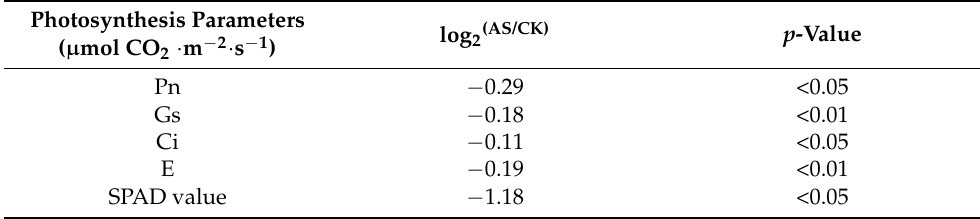
Table 2. The photosynthetic parameters of L. chinensis under normal and alkali conditions. The fold changes were calculated using the formula log 2(alkali/control) . Significant differences between control and alkali stress were defined with the t -test and labeled as p < 0.05 and p < 0.01. Photosynthesis